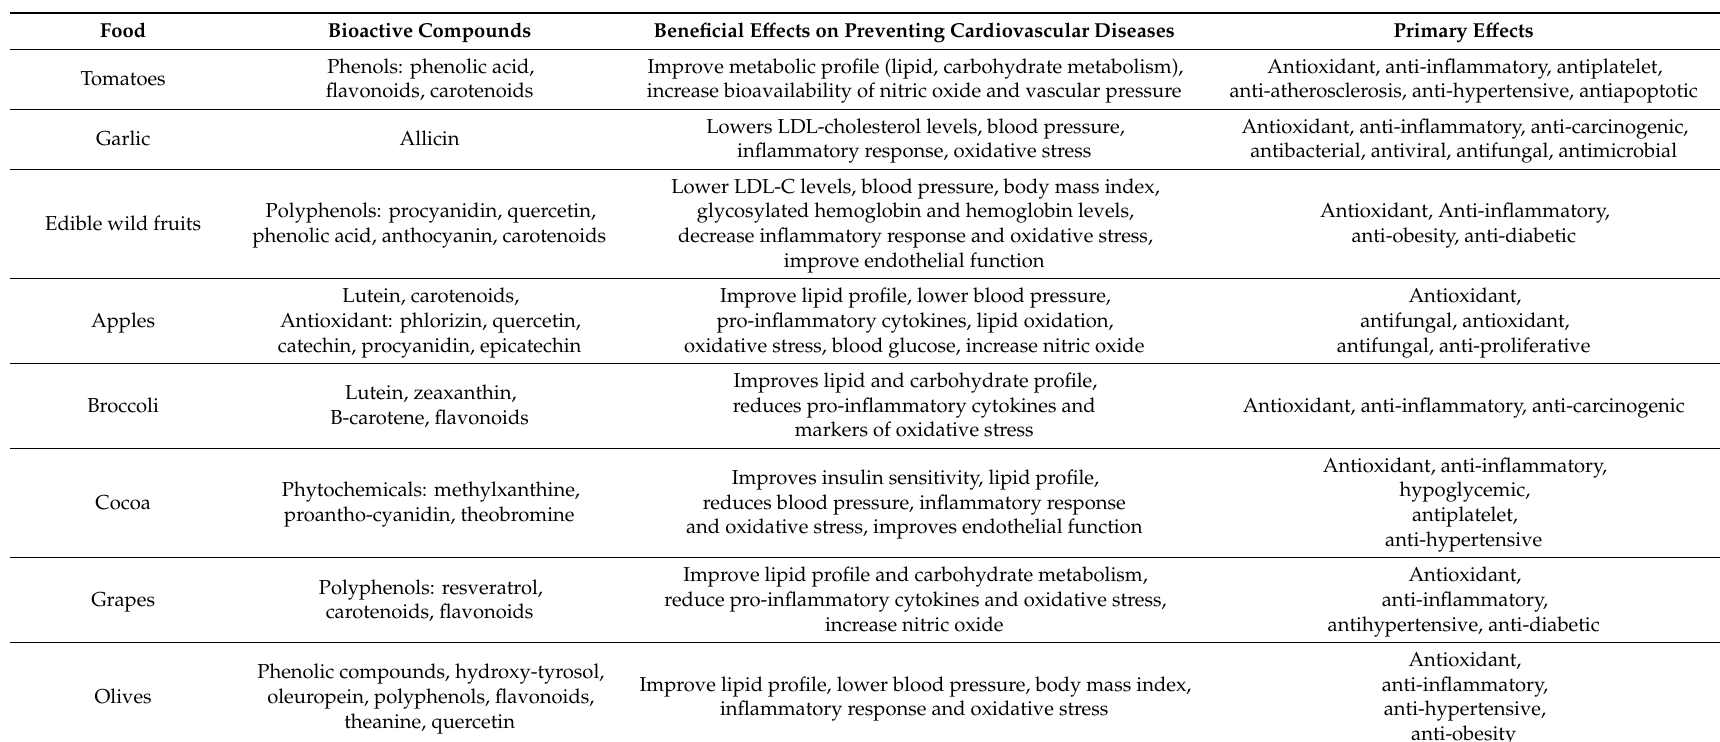
Table 2. Composition and beneficial e ff ects of certain foods rich in flavonoids